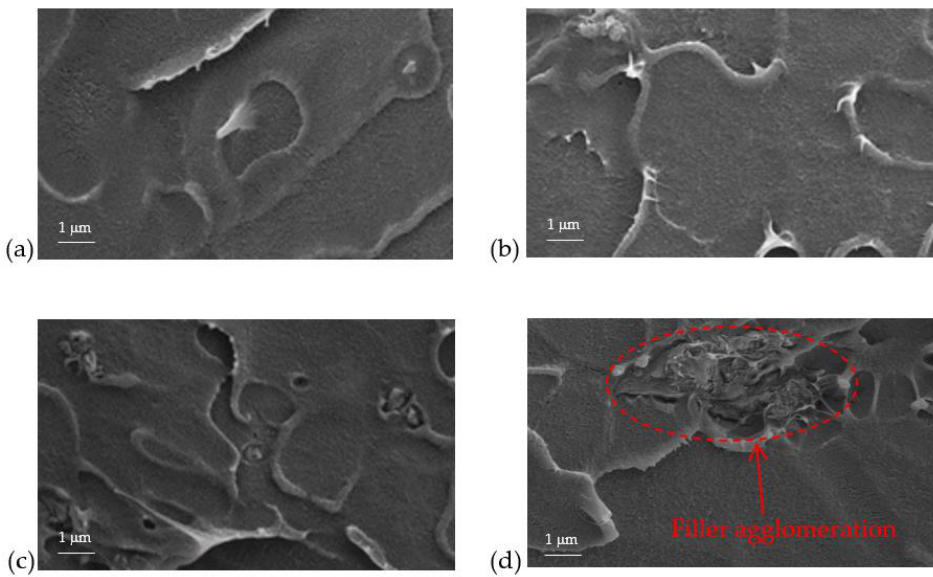
Figure 6. The cross-sectional view of FESEM images of ( a ) 1% NH 2 KIT-6/PSF, ( b ) 2% NH 2 KIT-6/PSF,